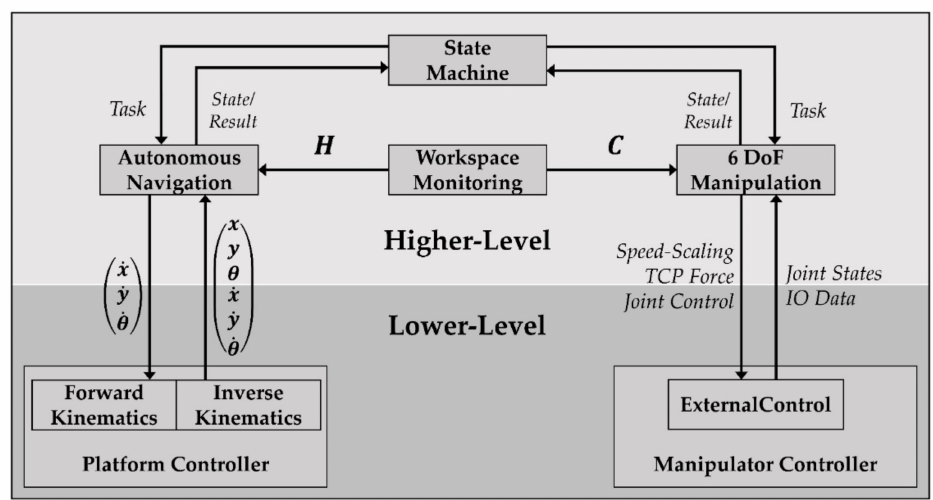
Figure 5. Main modules of the control software.